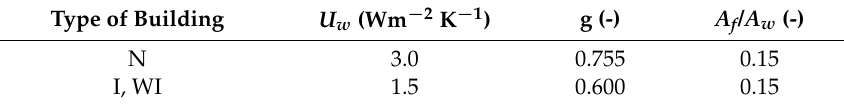
Table 2. Properties of the windows considered in this work.